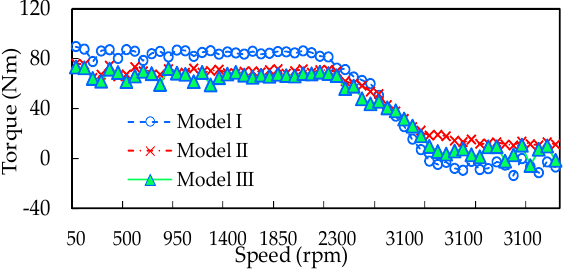
Figure 14. Torque-speed characteristic in different models when the torque command T e * = 90 nm.